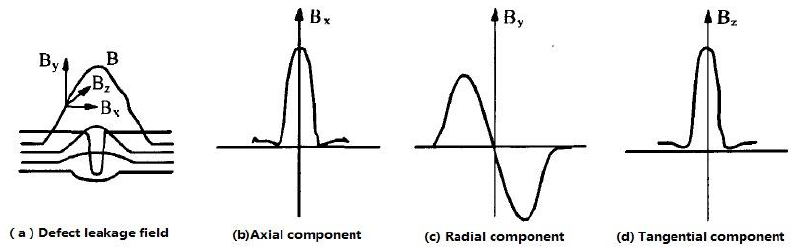
Figure 3. Defect leakage field and each component.